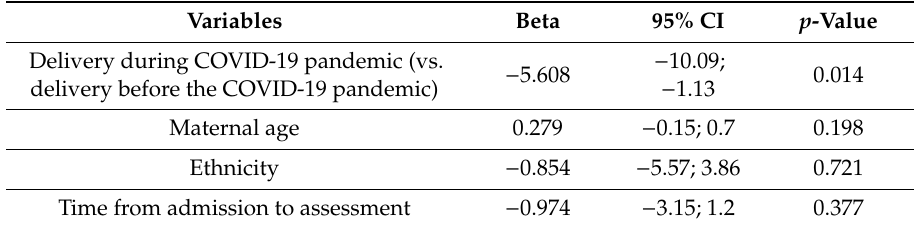
Table 4. Multivariable regression model for the association between delivery during COVID-19 pandemic and maternal subjective cognitive test (AFI).